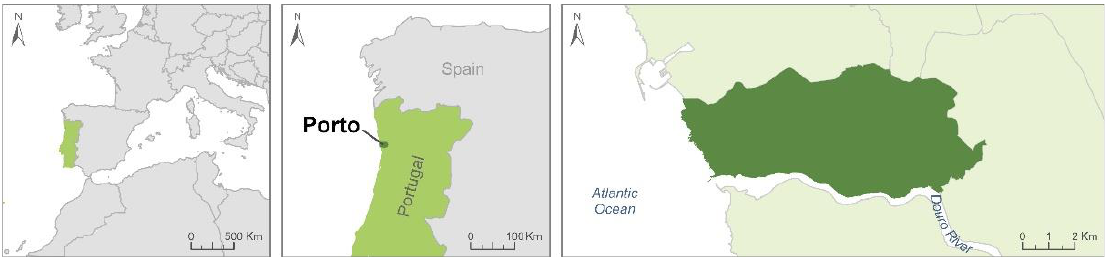
Figure 1. Location of the city of Porto, Portugal.